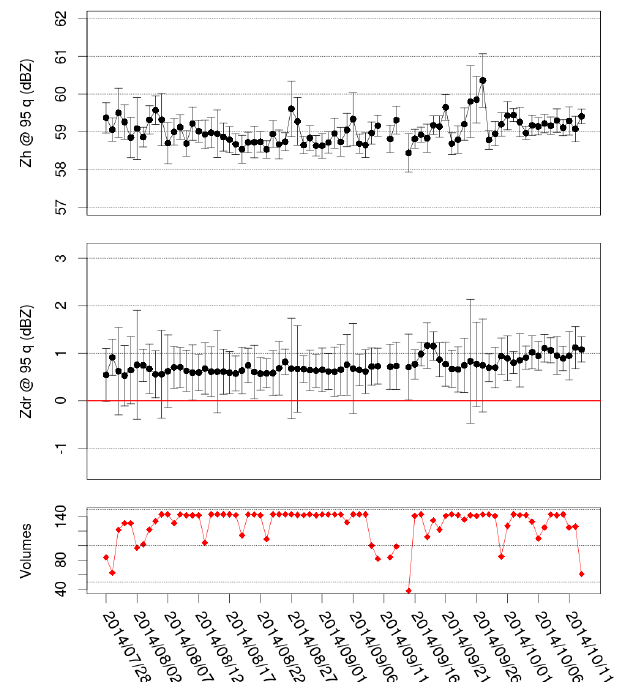
Figure 13. Daily mean values of the 95th percentile of all daily scans of Z H (top) and Z dr (center) ECDFs. The bottom plot shows the number of scans used to compute the daily mean values. The error bars represents the standard deviation.